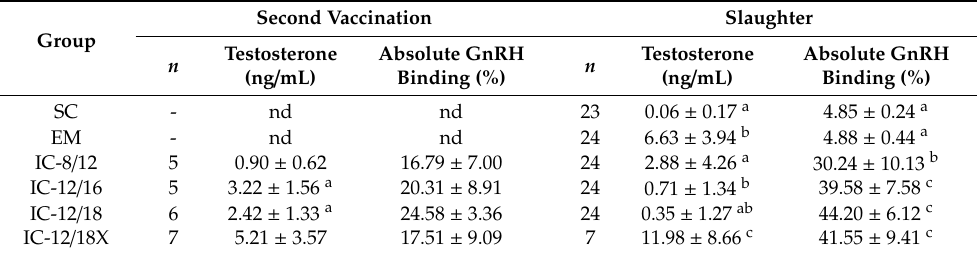
Table 3. Testosterone concentration (ng / mL) and absolute GnRH binding (%) (mean ± SD) in serum at second vaccination (V2) and slaughter (S) within the di ff erent groups (SC, EM, IC-8 / 12, IC-12 / 16, IC-12 / 18, IC-12 /